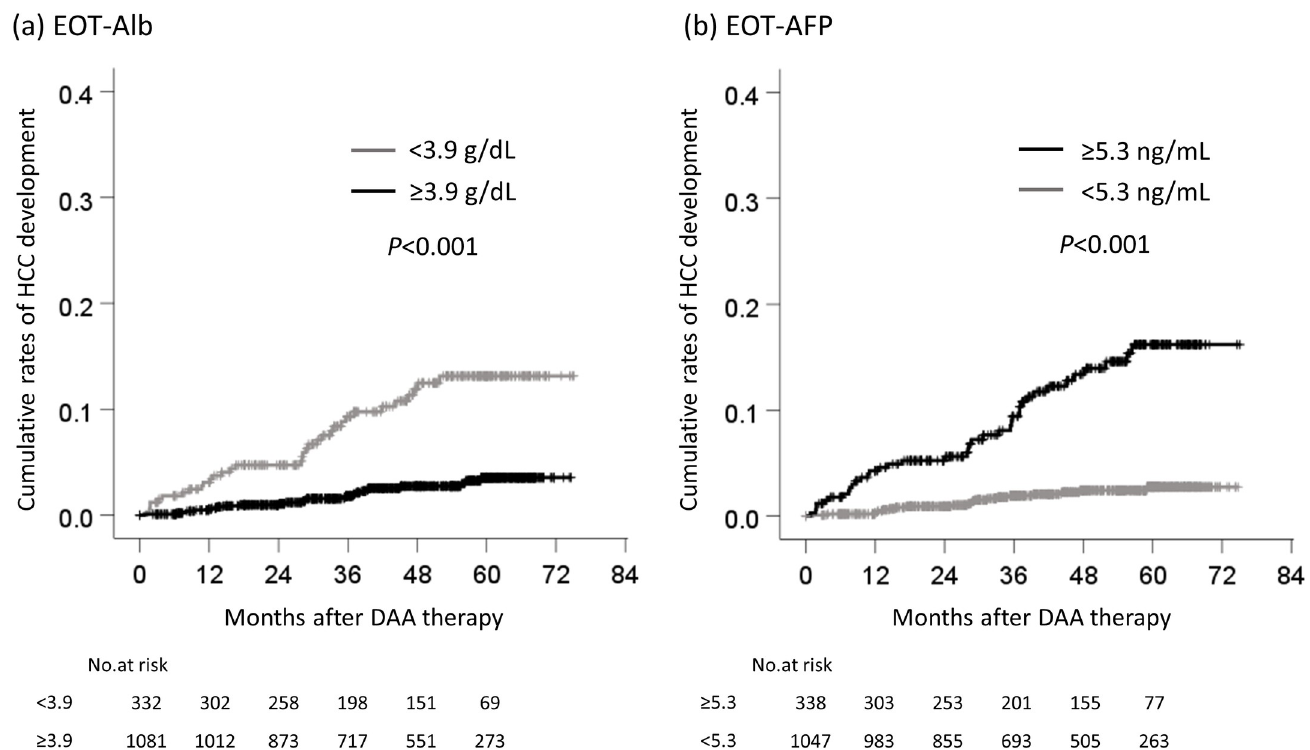
Fig 5. The cumulative rates of HCC development by albumin and alpha-fetoprotein at the end of treatment. (a) between EOT-Alb � 3.9 g/dL and < 3.9g/dL, (b) between EOT-AFP � 5.3 ng/mL and < 5.3 ng/mL. HCC, hepatocellular carcinoma; DAA, direct-acting antiviral; EOT, end of treatment; Alb, albumin; AFP,